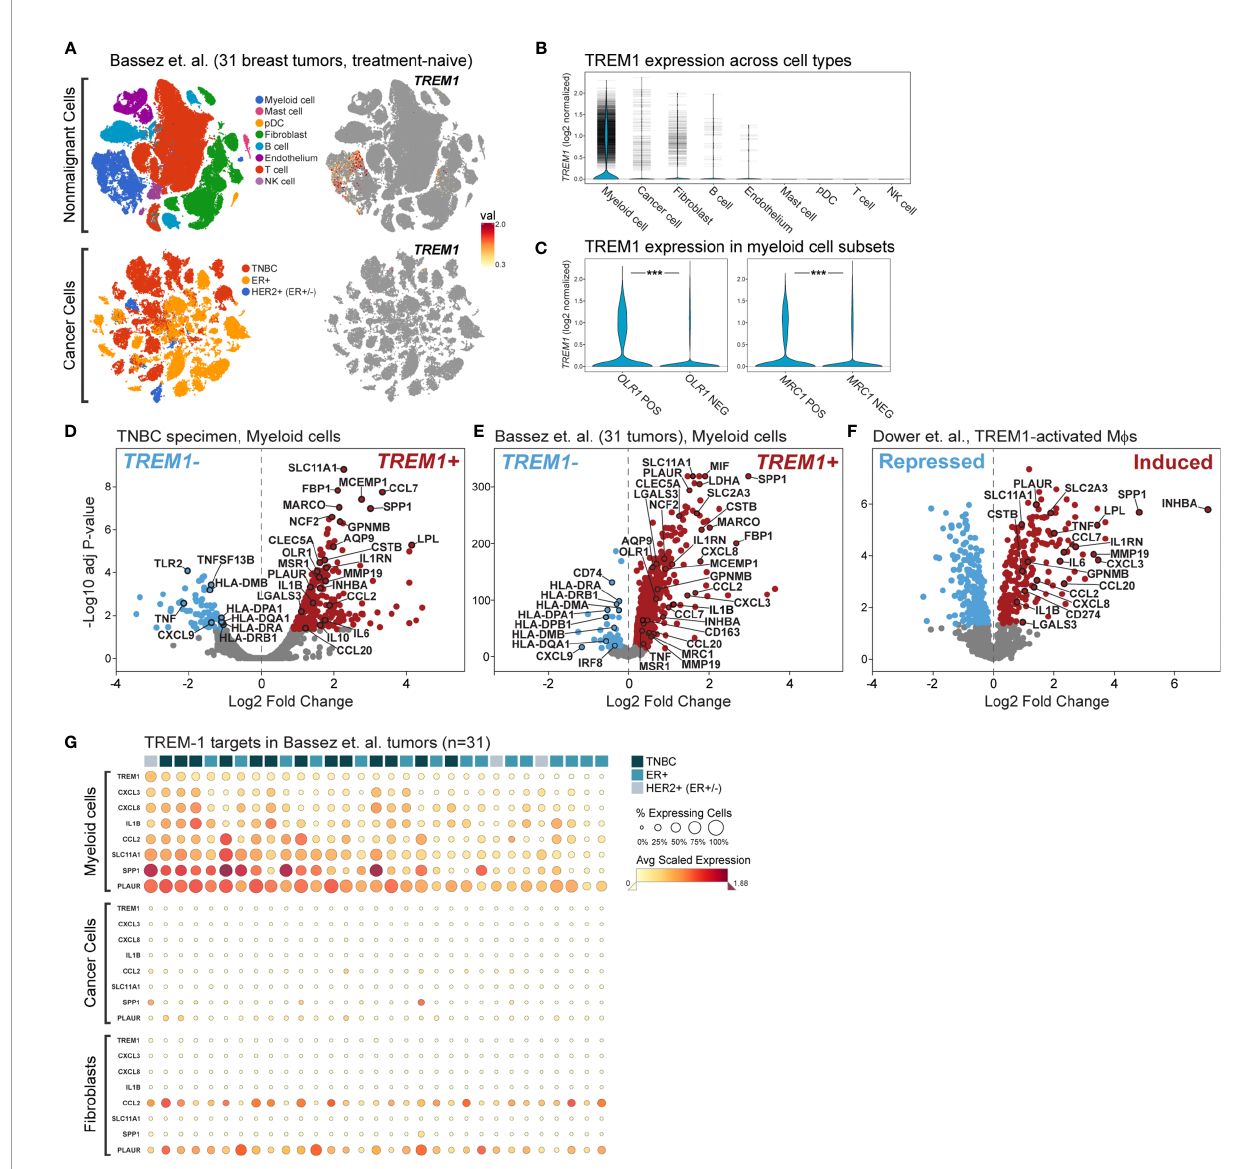
FIGURE 7 | Single cell analysis of TREM1 and correlated genes in a breast tumor panel. (A) Shown are tSNE plots derived from the Bassez et al. single cell RNAseq data for 175,942 cells from 31 primary breast tumors comprising TNBC (n = 13), ER + (n = 15) and HER2 + /ER +/- (n = 3) subtypes. Plots are shown for nonmalignant cells (upper panels) and cancer cells (lower panels). The magnitude of TREM1 expression across cell populations is illustrated spatially (right panels), and in (B) violin plots across cell types. Horizontal tick marks denote individual cell measurements. (C) TREM1 expression is compared between myeloid cells grouped according to positive or negative expression of OLR1 (MDSC marker, left panel) or MRC1 (M2 TAM marker, right panel). *** P < 0.001. Volcano plots of genes differentially expressed between myeloid cells positive or negative for TREM1 expression are shown for (D) the WFBMC TNBC specimen [204 genes differentially expressed between TREM1+ cells (n=123) and TREM1 – cells (n = 178)], and (E) the set of 31 breast tumors of Bassez et al. [3,223 genes differentially expressed between TREM1+ cells (n = 3,333) and TREM1 – cells (n = 13,152)]. (F) Volcano plot of genes differentially expressed between TREM-1-activated (agonist Ab-treated) and control (isotype Ab-treated) human blood monocytes of Dower et al. [2,010 genes differentially expressed between treated samples (n = 11) and control samples (n = 11)] (24). (G) Heatmap of average gene expression levels of TREM1 and select target genes in myeloid, cancer, and fi broblast cell populations of individual tumors. Tumor samples (columns) are ranked left to right (descending order) according to the percentage of TREM1 -expressing cells in the myeloid